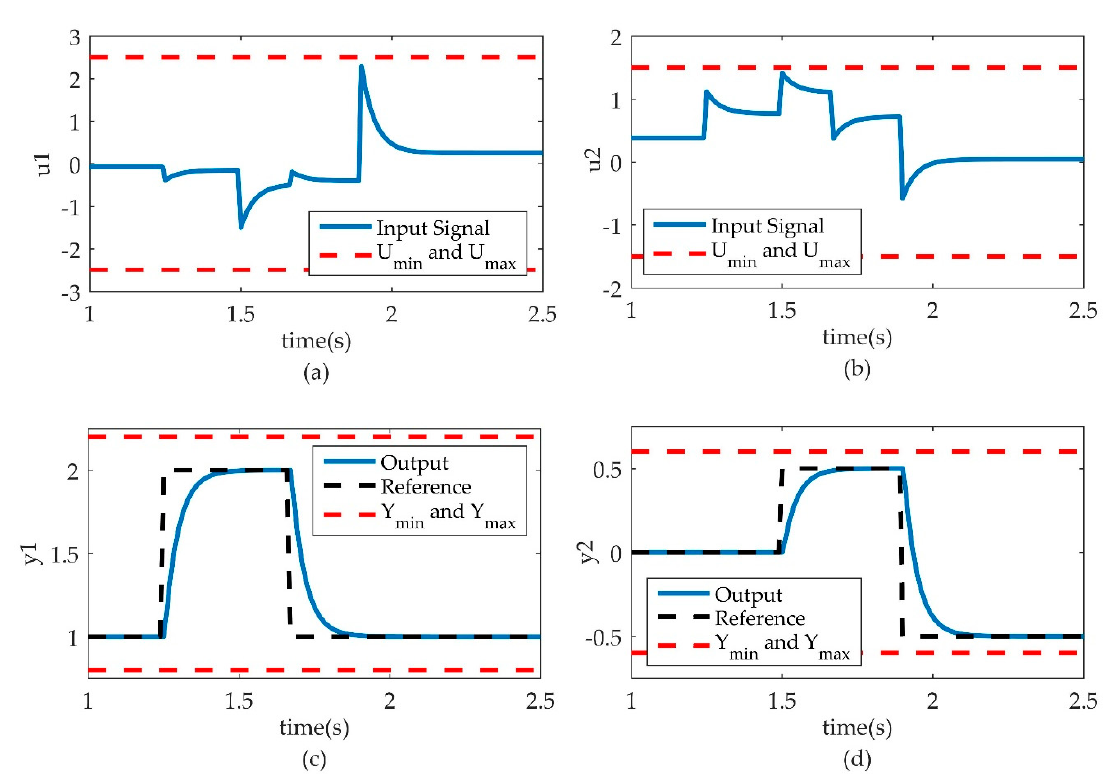
Figure 1. Closed-loop response for the same dead times. ( a ) The first control signal; ( b ) the